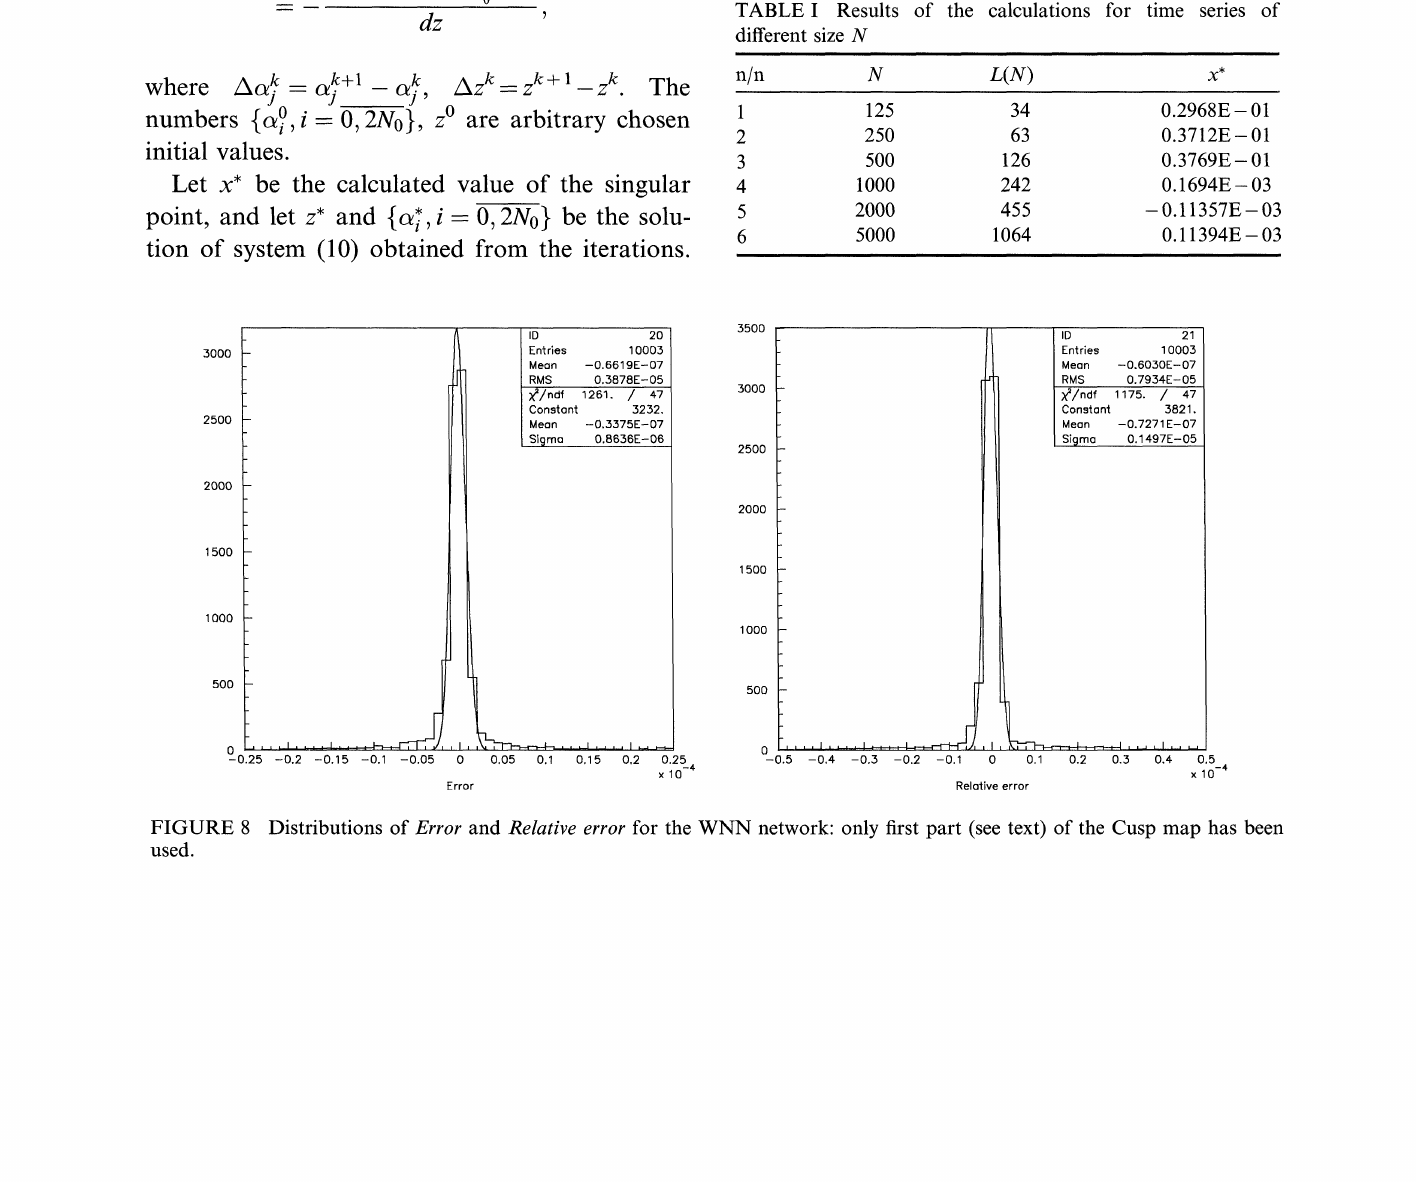
Results of the calculations for time series of different size N